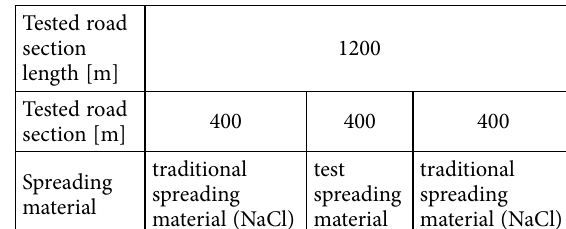
Table 6. Typical road measurement scheme